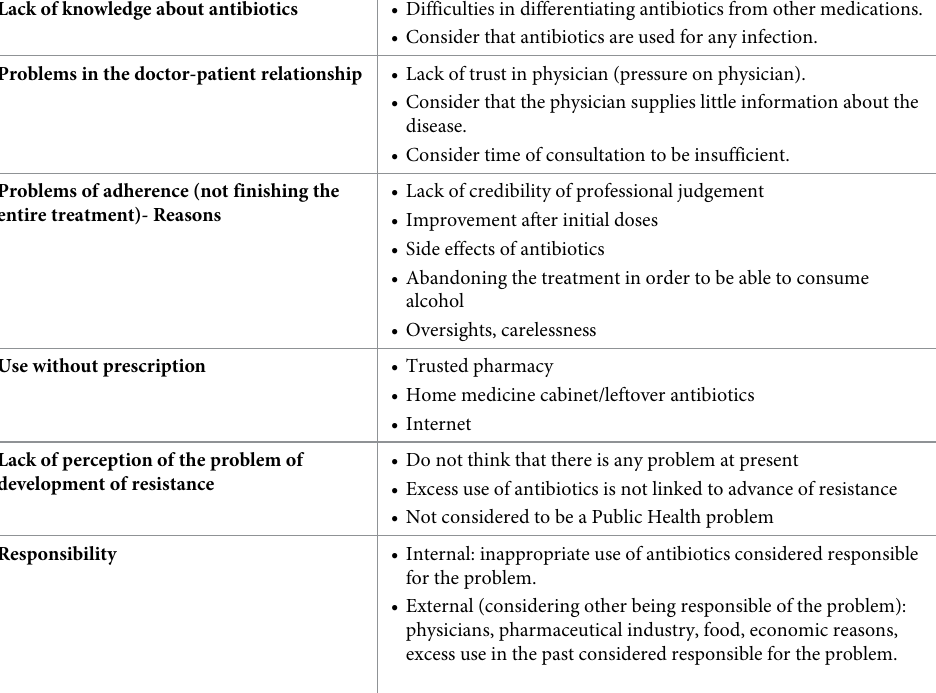
Table 2. Coding of the results identified in the